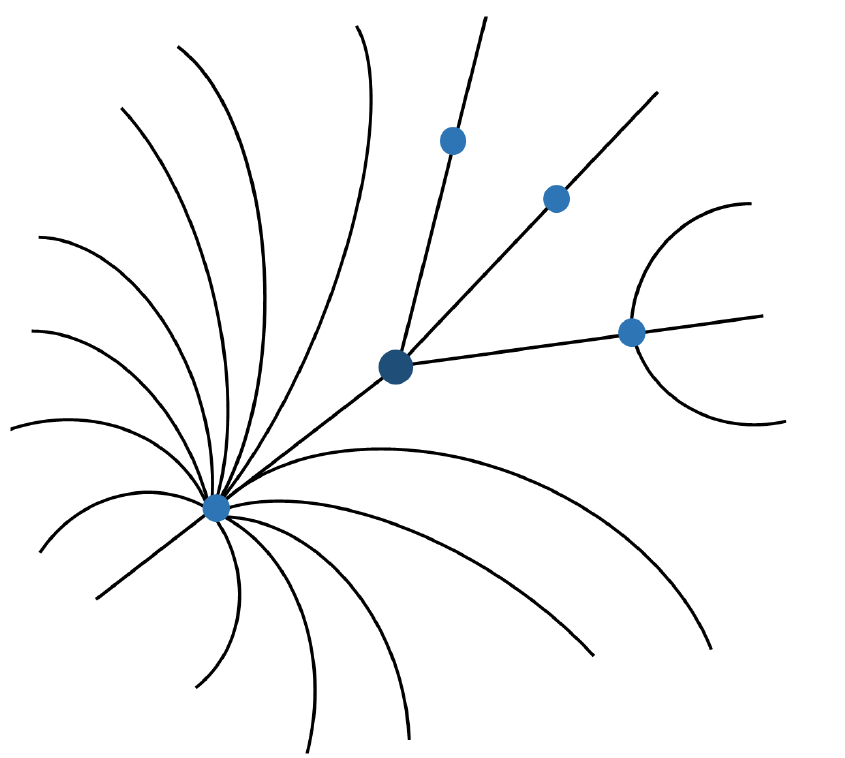
Figure 3. UI mockup proposal of graph